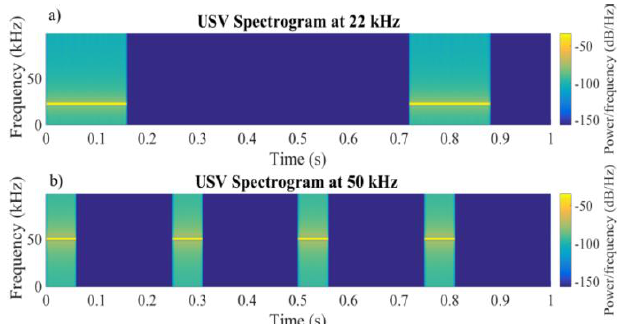
Figure 2. Ultrasound vocalizations (USVs) at 22 kHz with an overall duration of 7.92 s (each one consisted of 11 calls of 0.16 s) ( a ) and at 50 kHz with a duration of 6.74 s (26 calls of 0.06 s) ( b ). The vocalizations were presented to the rats 20 times.